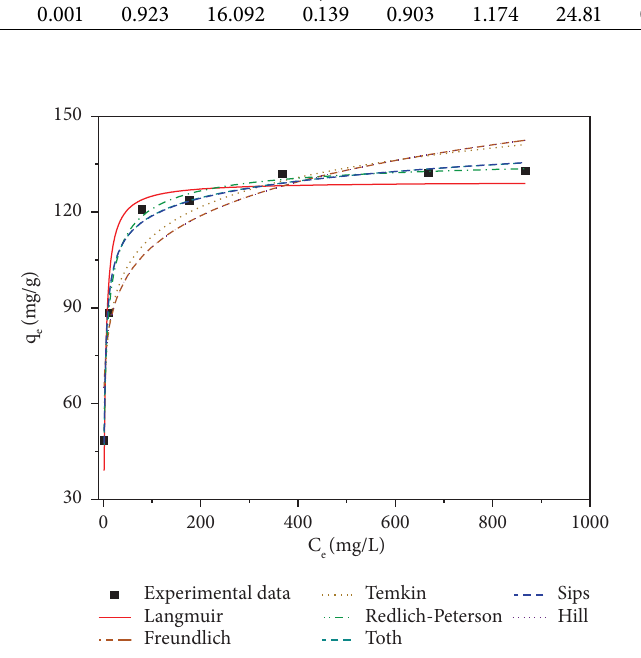
Figure 5: Te adsorption-desorption experiments of FeMn-EDTA-LDHs.